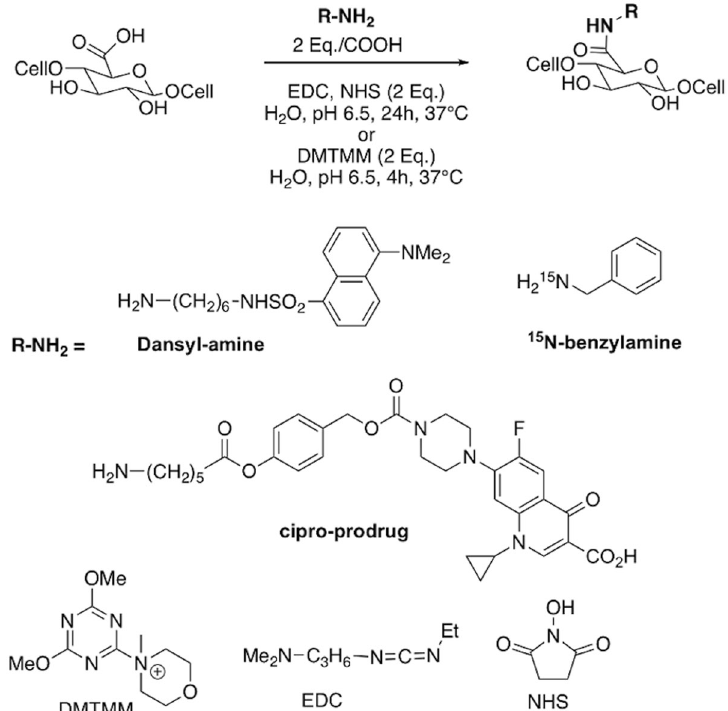
Fig. 1 Amidation reaction and coupling agents. Covalent binding of various amino-substituted compounds (Dansyl-amine, 15 N-benzylamine, cipro- prodrug) on CNF-t using either EDC/NHS or DMTMM as coupling agents. Chemical structures of the coupling agents are given at the bottom of the fi